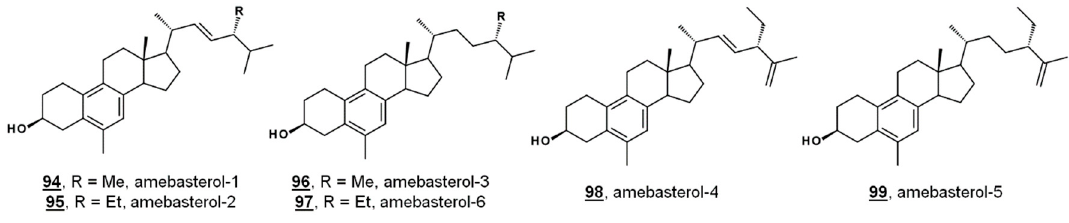
Figure 9. Structures of amebasterols.